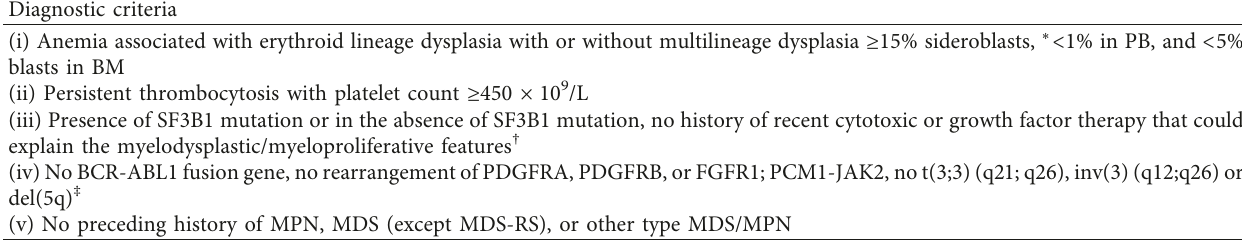
Table 1: Diagnostic criteria for MDS/MPN with RS-T according to WHO 2016 classification [3]. Diagnostic